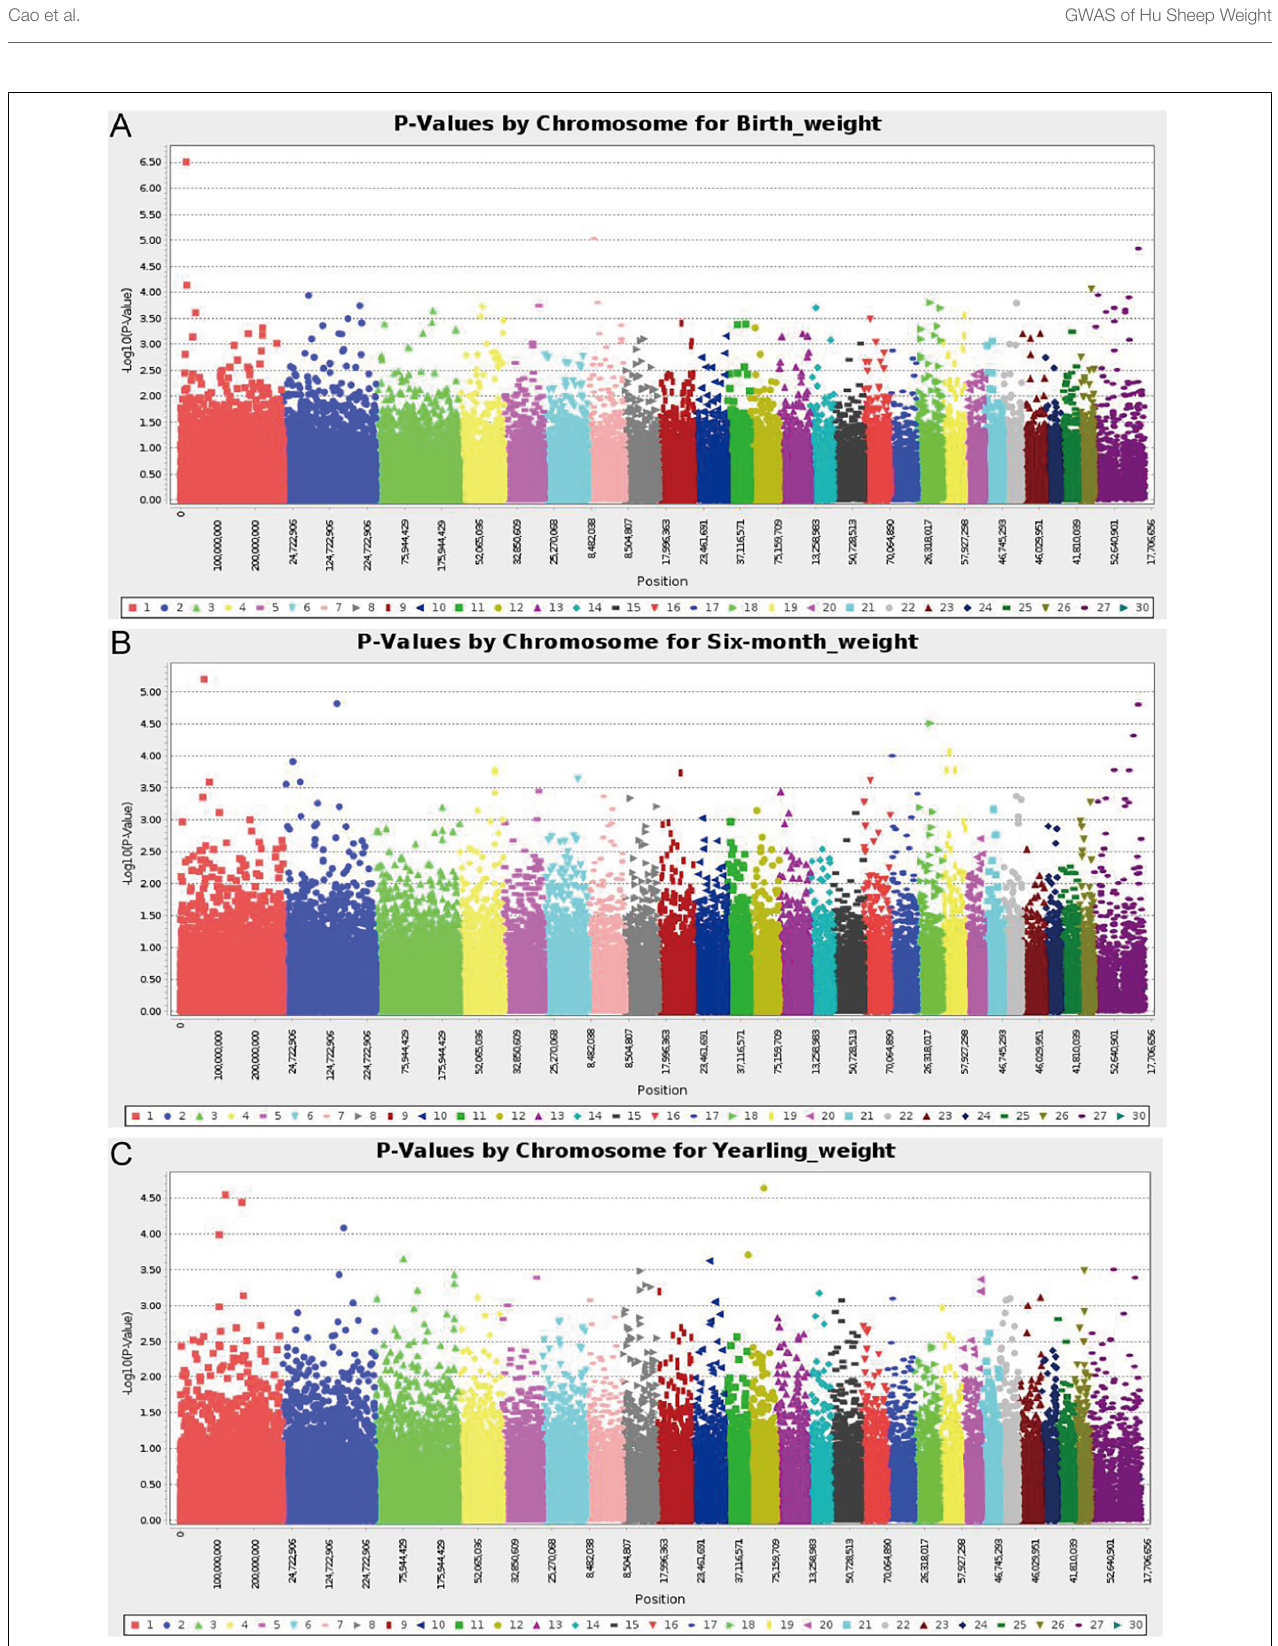
FIGURE 2 | Manhattan plot of analysis results; -log 10 ( p values) in the studied population of Hu sheep. (A) Manhattan plot of the results of the birth weight analysis; (B) Manhattan plot of the results of the 6-month weight analysis; (C) Manhattan plot of the results of the yearling weight analysis.